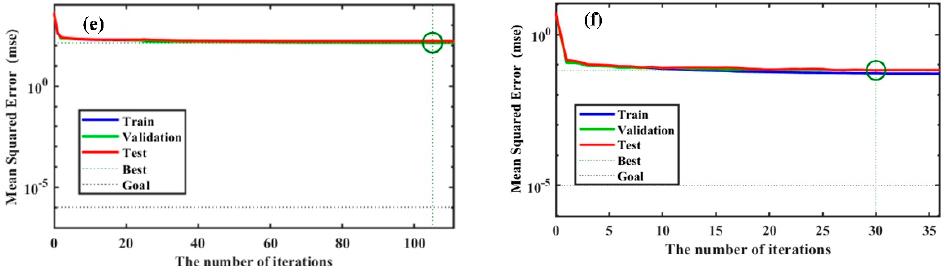
Figure 13. Comparison of the prediction results of BP and GA-BP neural network algorithms. ( a ) prediction results of BP neural network, ( b ) prediction results of GA-BP neural network, ( c ) R 2 of BP neural network, ( d ) R 2 of GA-BP neural network, ( e ) number of iterations of BP neural network, ( f ) number of iterations of GA-BP neural network. Table 4. Comparison of the accuracy of BP and GA-BP results.